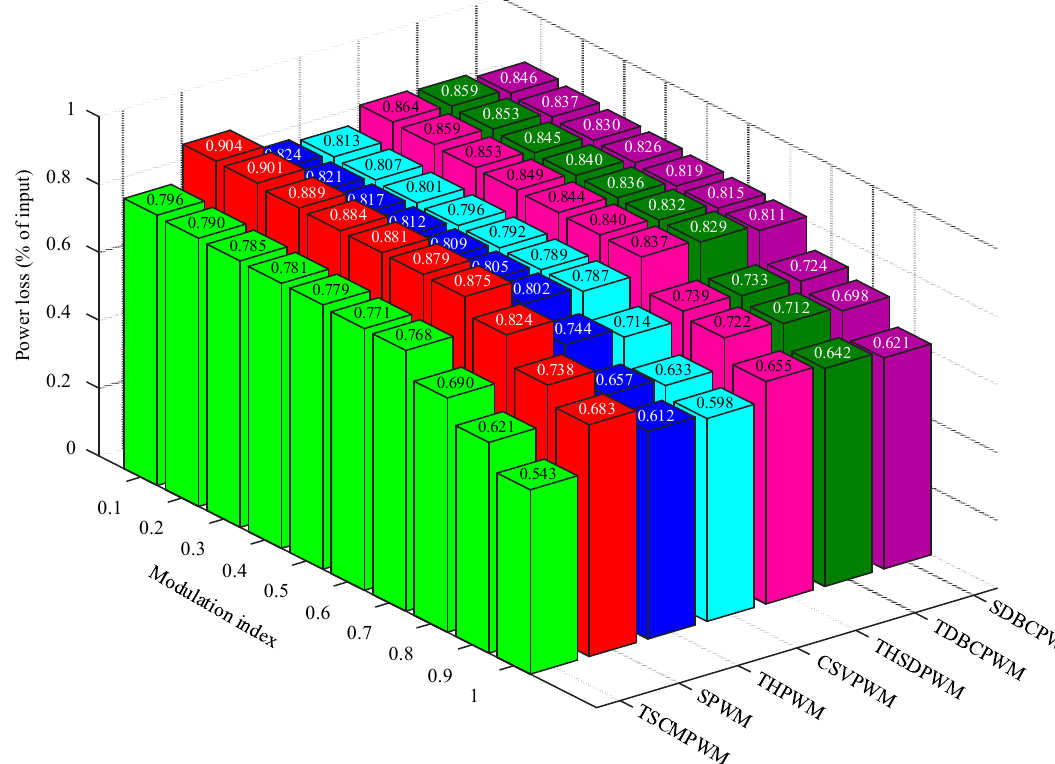
Figure 17. Inverter power loss for different PWM techniques with the variation of modulation index at 2 kHz carrier frequency.